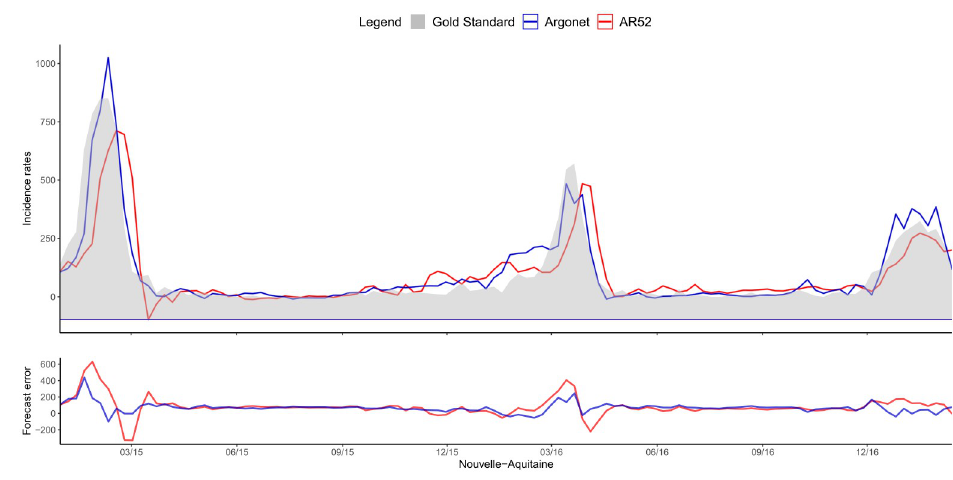
Fig 8. Nouvelle-Aquitaine real time